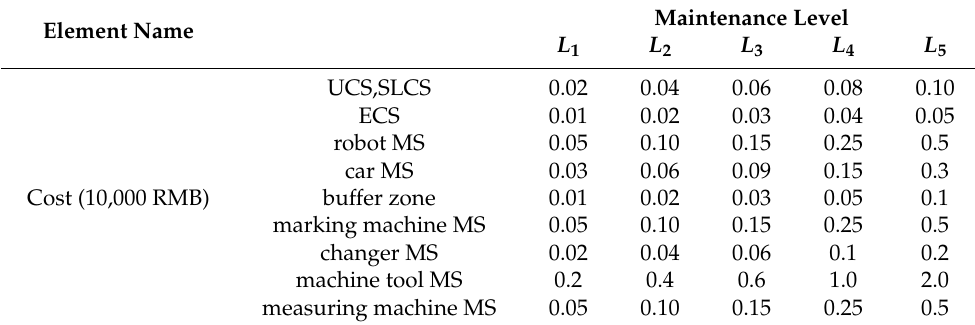
Table 4. Maintenance costs of elements under different